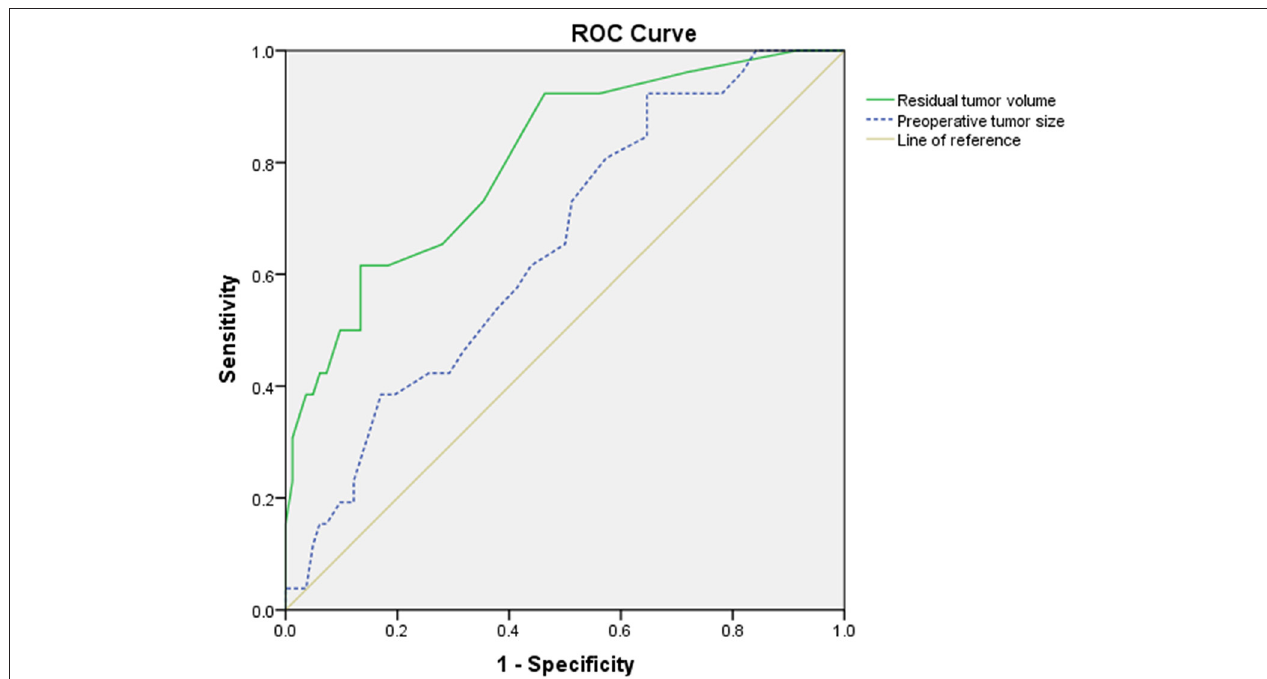
FIGURE 2 | The receiver operating characteristic (ROC) curve of preoperative tumor size (blue dotted line) and residual tumor volume (green solid line). The area under the curve (AUC) was 0.651 and 0.805, respectively. The cutoff point of preoperative tumor size was 26.5mm, with 0.923 sensitivity and 0.354 specificity, whereas the cutoff point of residual tumor volume was 95 mm 3 , with 0.615 sensitivity and 0.866